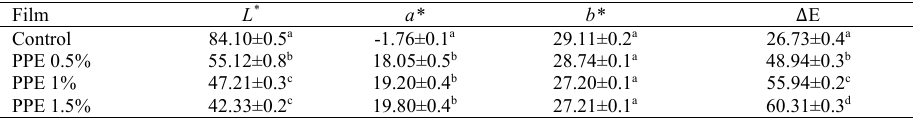
Table 2. Color of chitosan-ZnO films containing different concentrations of pomegranate peel extract (PPE)